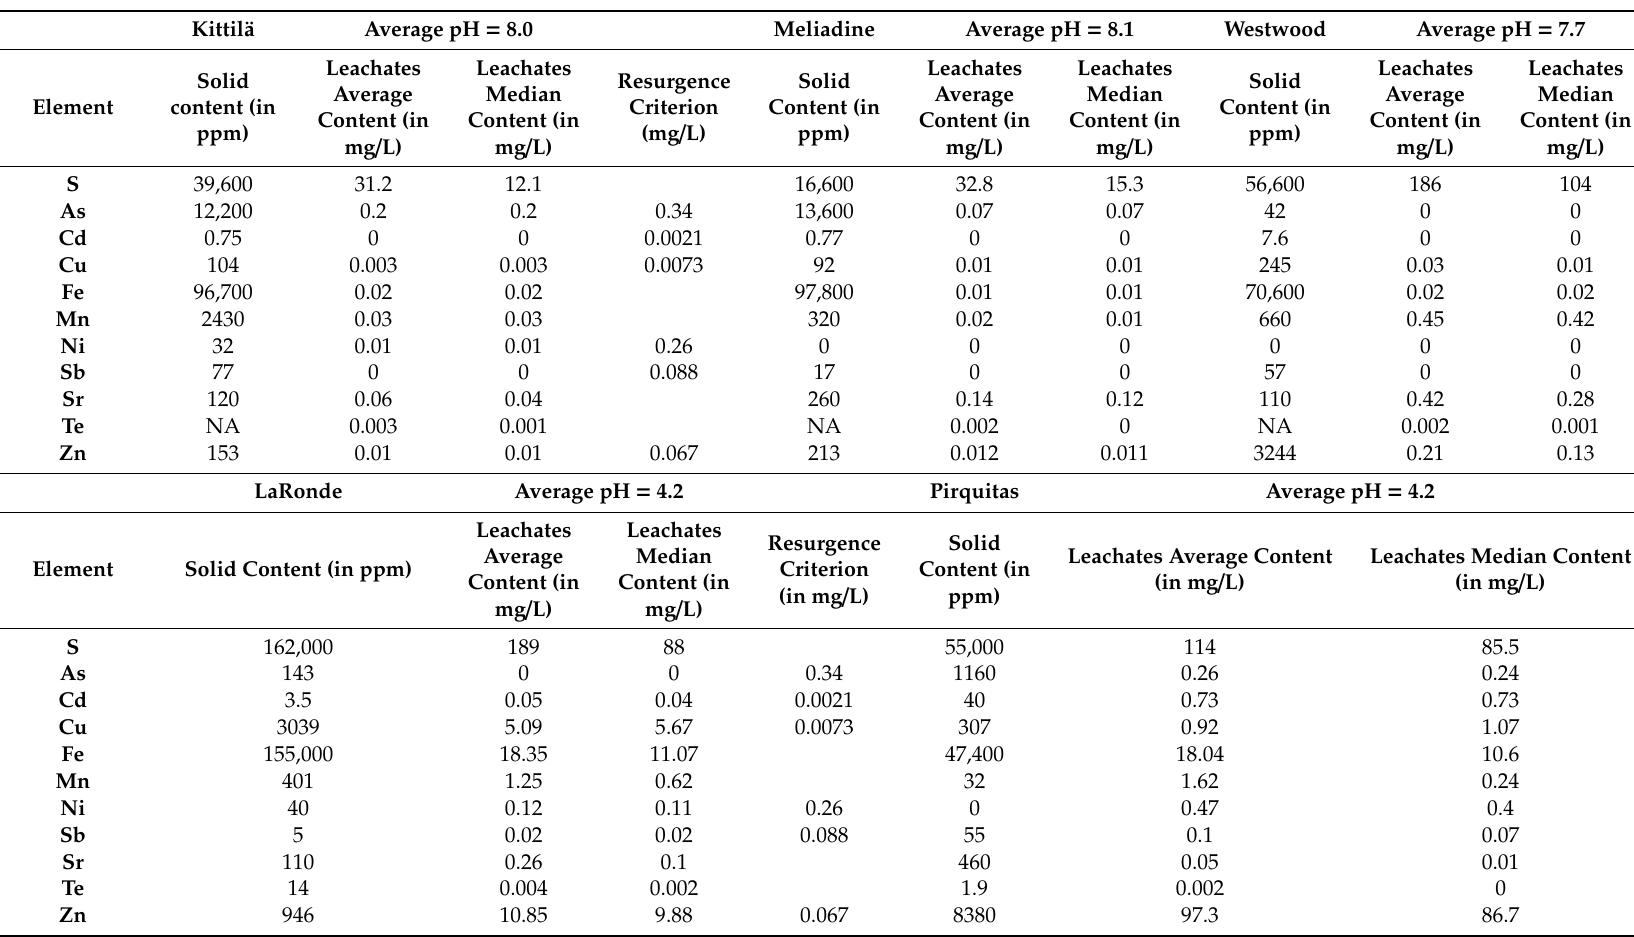
Table 4. Initial content and metal concentrations in the leachates of geochemical testing in the Kittilä, Meliadine, Westwood, LaRonde and Pirquitas ore samples. Kittilä Average pH = 8.0 Meliadine Average pH =